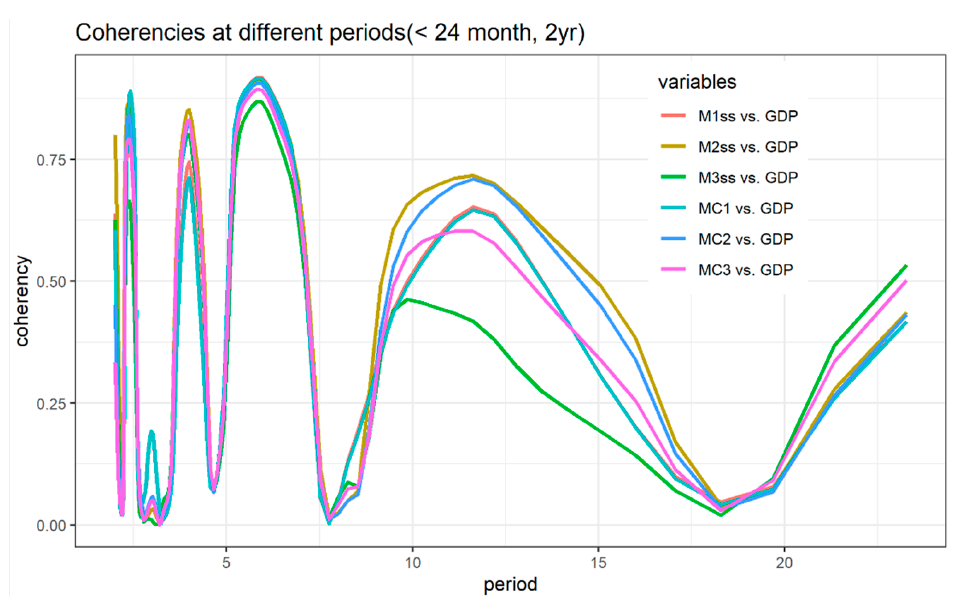
Figure 8. Coherencies with short periods.